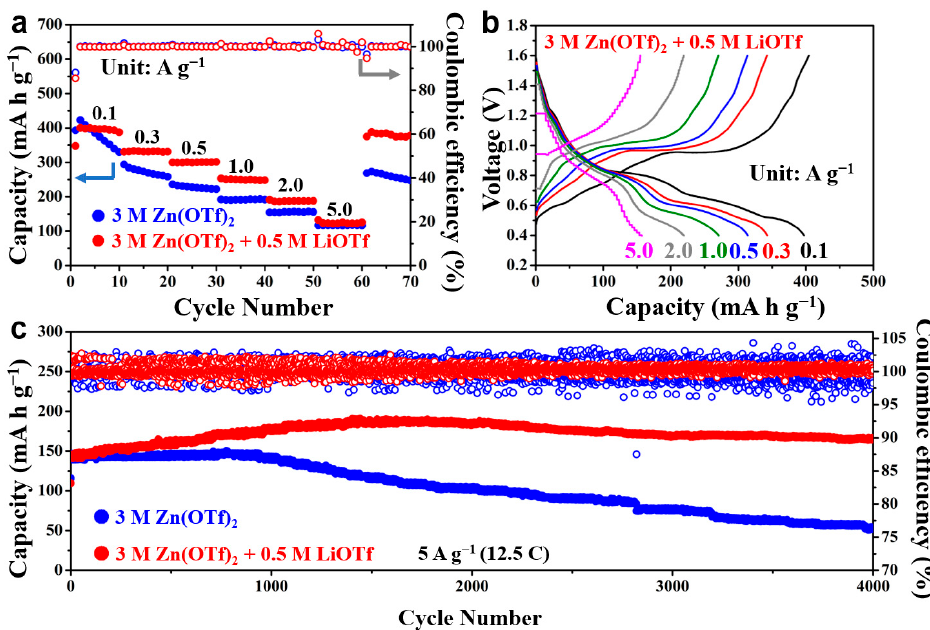
Figure 4. ( a ) Rate capability of the two batteries at different current densities; ( b ) galvanostatic charge and discharge profiles of the hybrid battery at different current densities; ( c ) long-cycle stability of the two batteries at 5.0 A g − 1